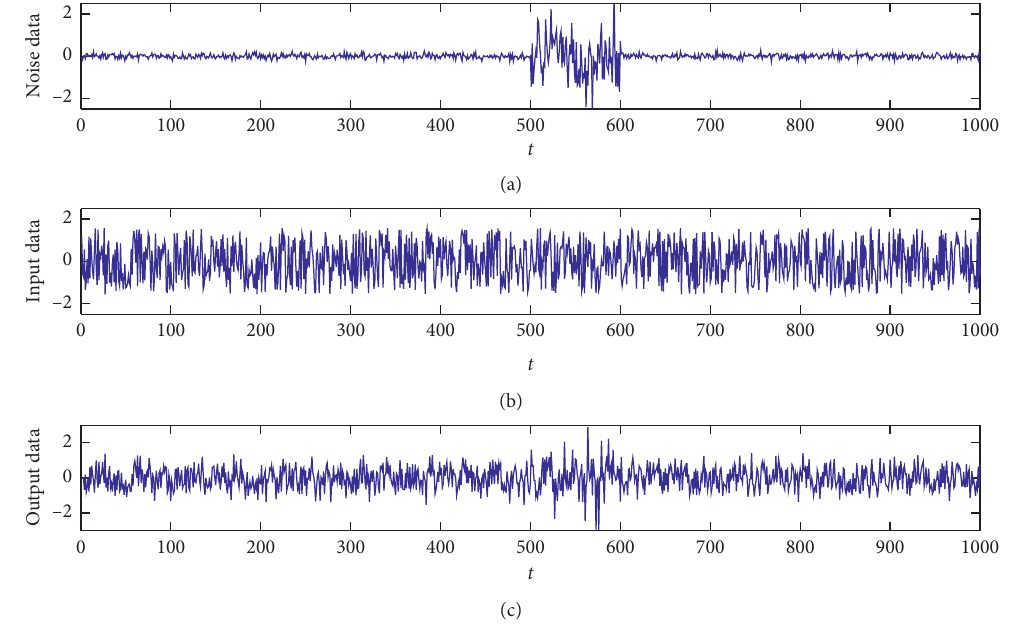
Figure 1: The simulation data. Table 1: The parameter estimates and errors.